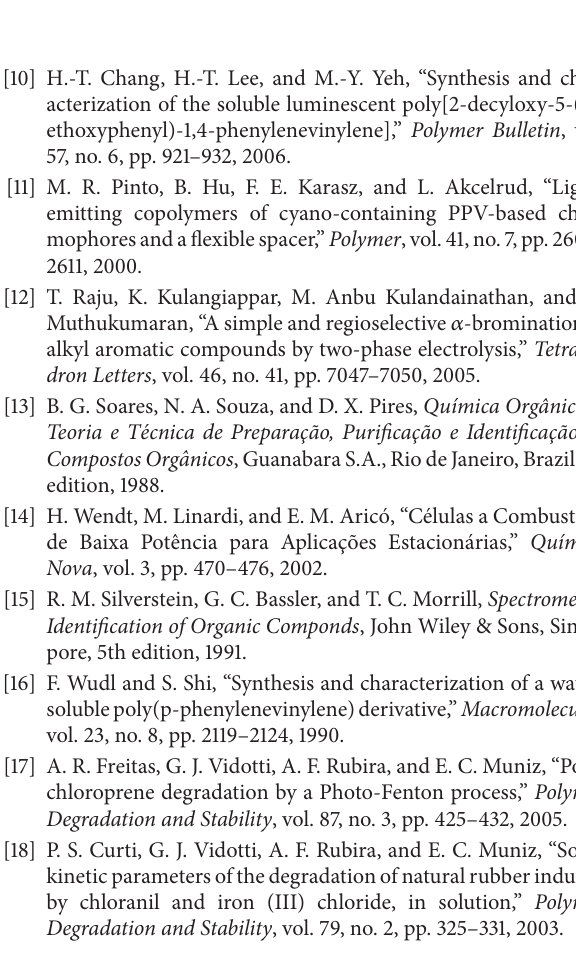
Figure 10: Mass spectra of